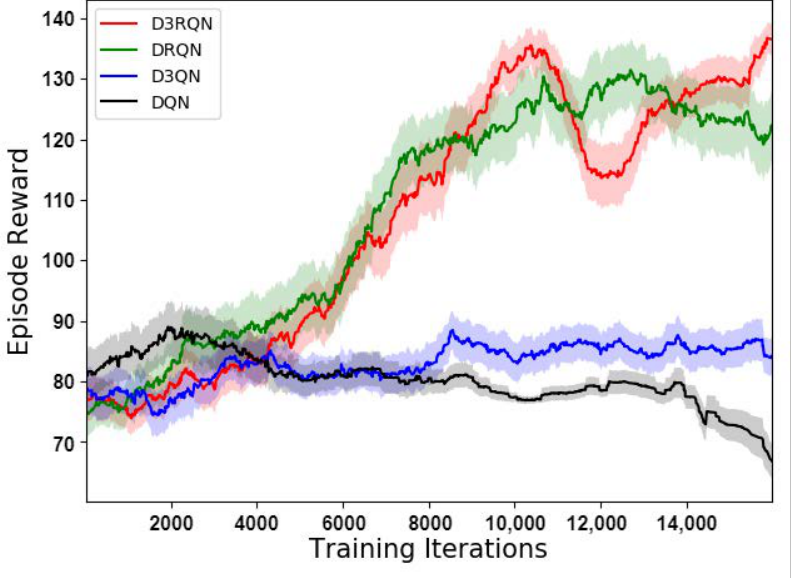
Figure 13. The learning curve of the obstacle avoidance